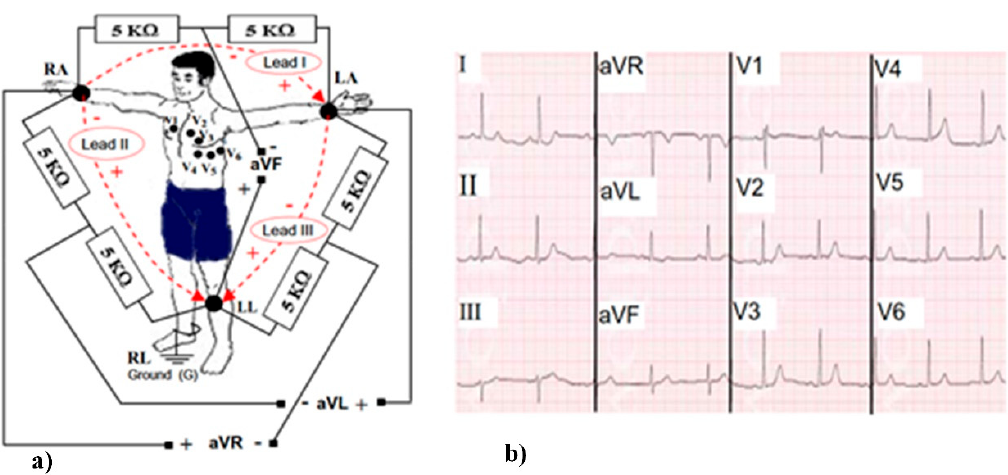
Figure 4. Schematic representation of electrocardiography (ECG) [69]: ( a ) 12-lead ECG: RA, LA, LL, RL; ( b ) example of ECG signals.